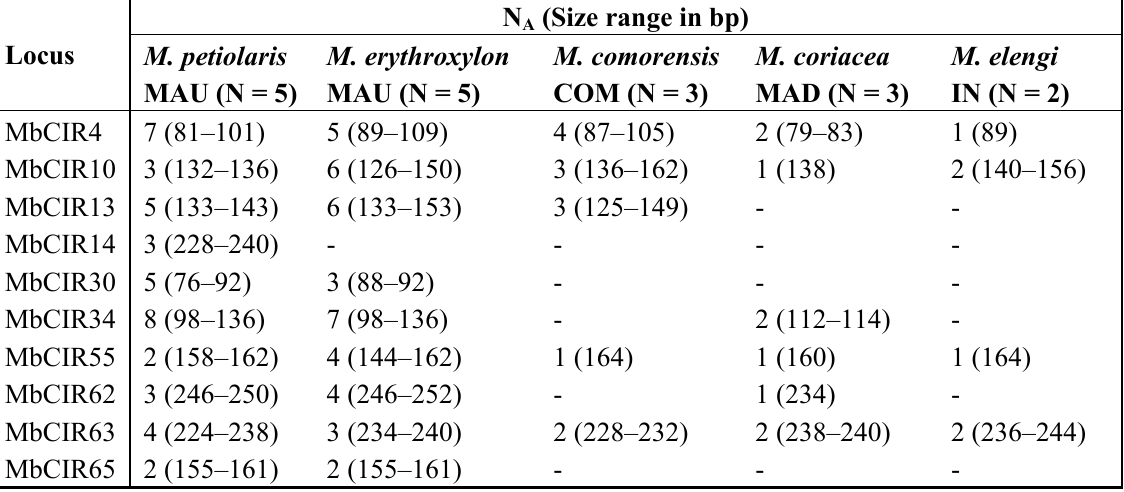
N (Size range in A